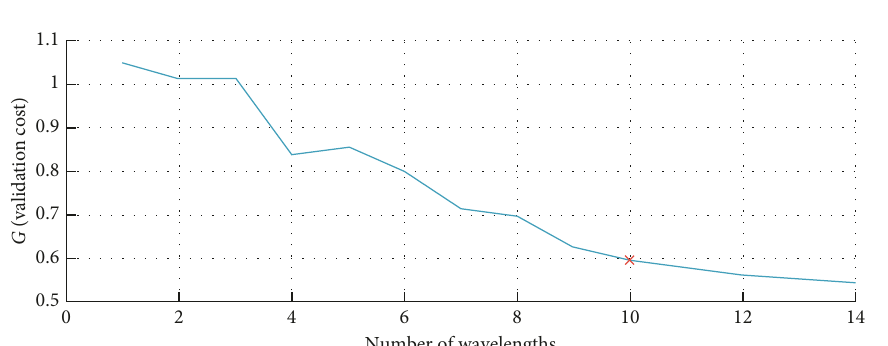
Figure 4: The G values under different numbers of wavelengths. The red × means the selected number of wavelengths.